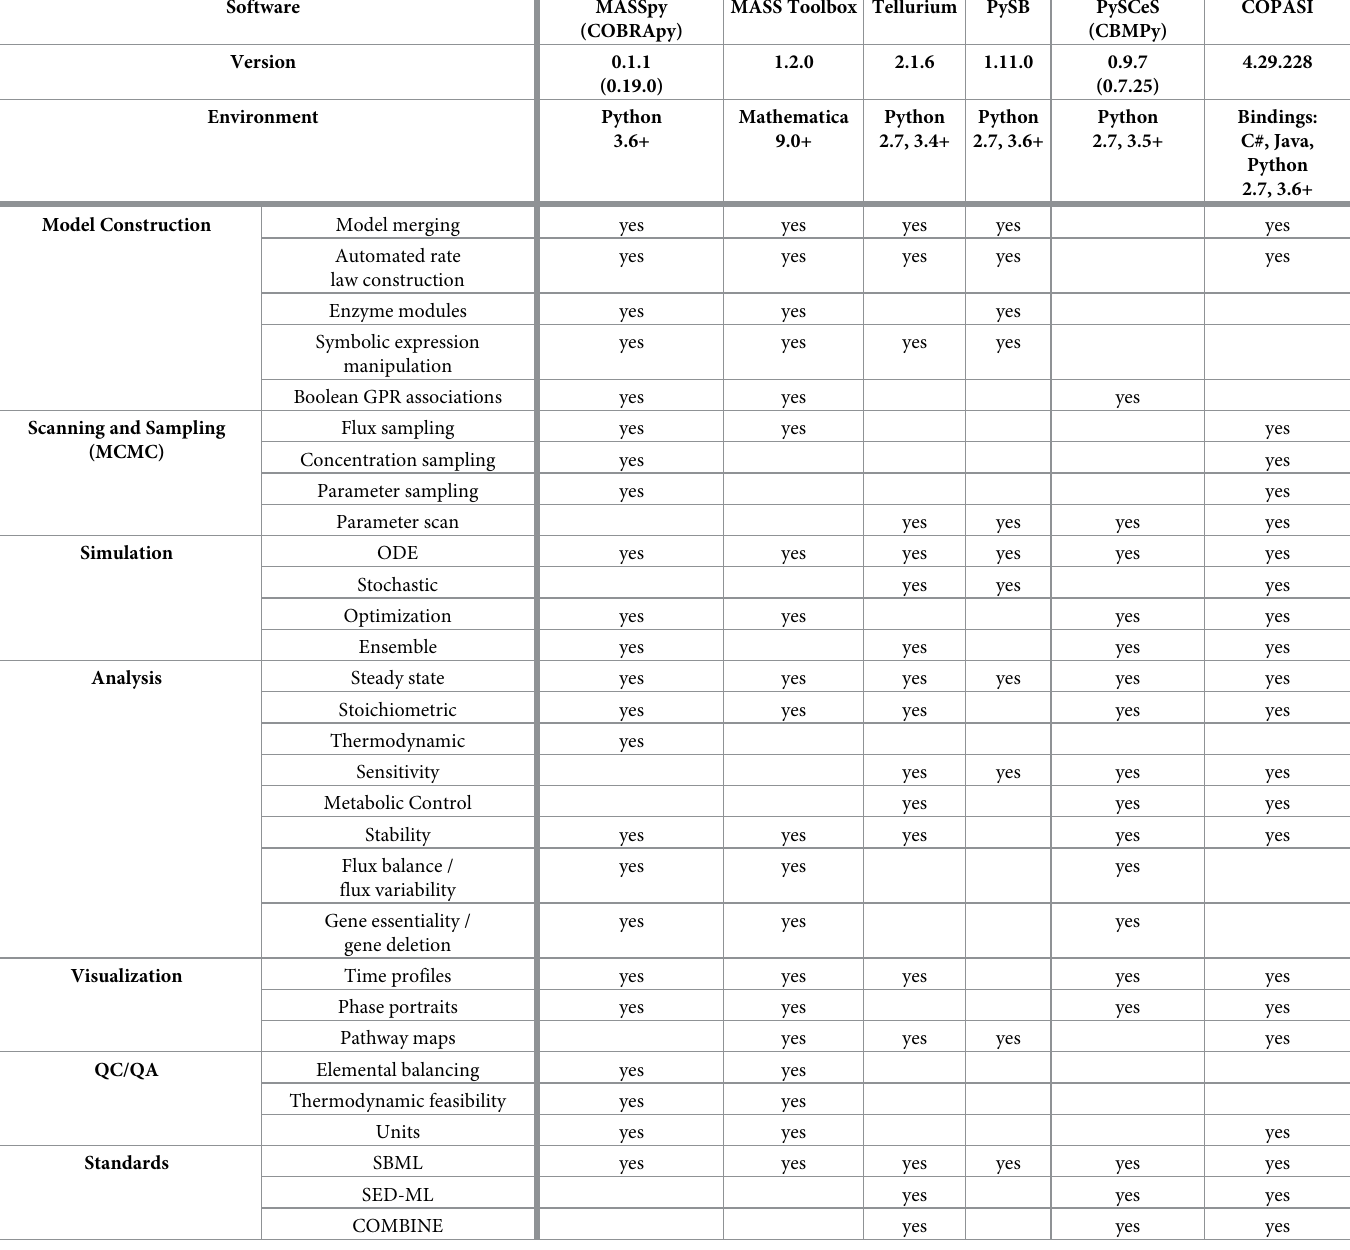
Table 2. Comparison of explicit helper methods for selected dynamic modeling